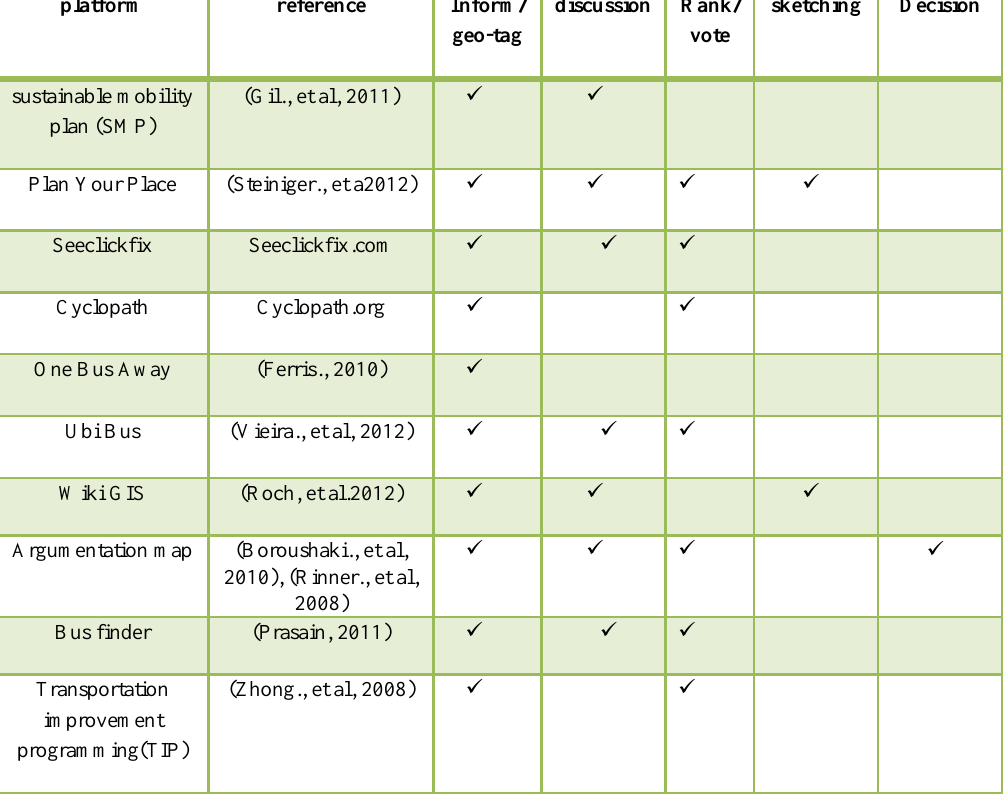
Table 2: classification of VGI based transport platforms based on the models of